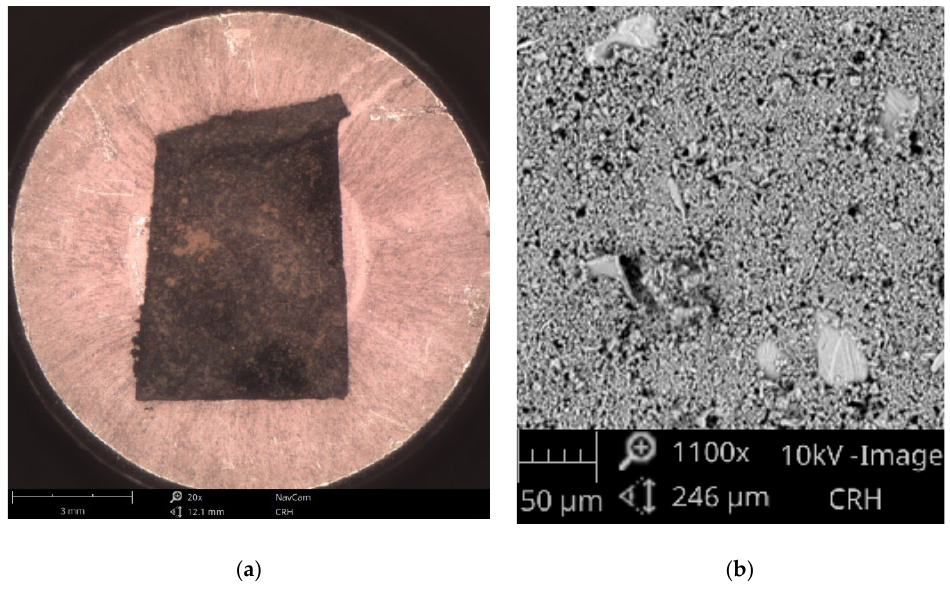
Figure 2. ( a ) Picture of dried lime slurry sample. ( b ) Surface image of calcareous groats grains made by scanning electron microscopy (SEM) with 1100 magnifications.